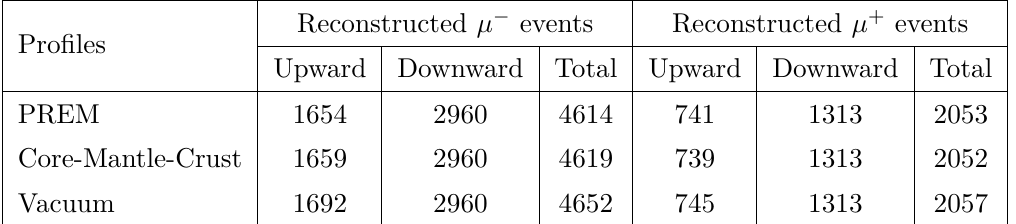
Table 3 . The total number of reconstructed µ − and µ + events expected in the upward and downward direction at the 50 kt ICAL detector in 10 years which is scaled from 1000-year MC